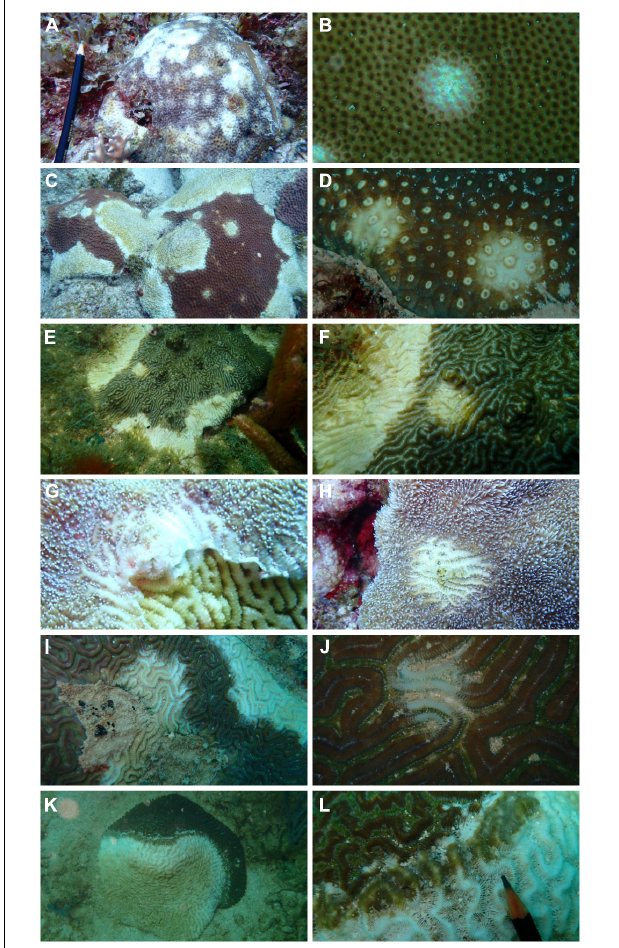
FIGURE 2 | Examples of consistent differentiating signs on different species of corals affected by Stony Coral Tissue Loss Disease (SCTLD). A multifocal bleached round area is observed in areas where the lesion is apparently initiating. This blotch was never seen or reported for WPD. Multifocal coalescent infection on Siderastrea siderea (A) and a close up of a bleached small lesion (B) , Montastraea cavernosa (C,D) , Pseudodiploria strigosa (E,F) and Dendrogyra cylindrus (G,H) and Diploria labyrinthiformis (I,J) . A front of sloughing tissue between apparently healthy and recently exposed skeleton suggest rapid mortality is ongoing on Pseudodiploria strigosa (K,L) . Photos taken at Carriles, Sanama, Dominican Republic in March